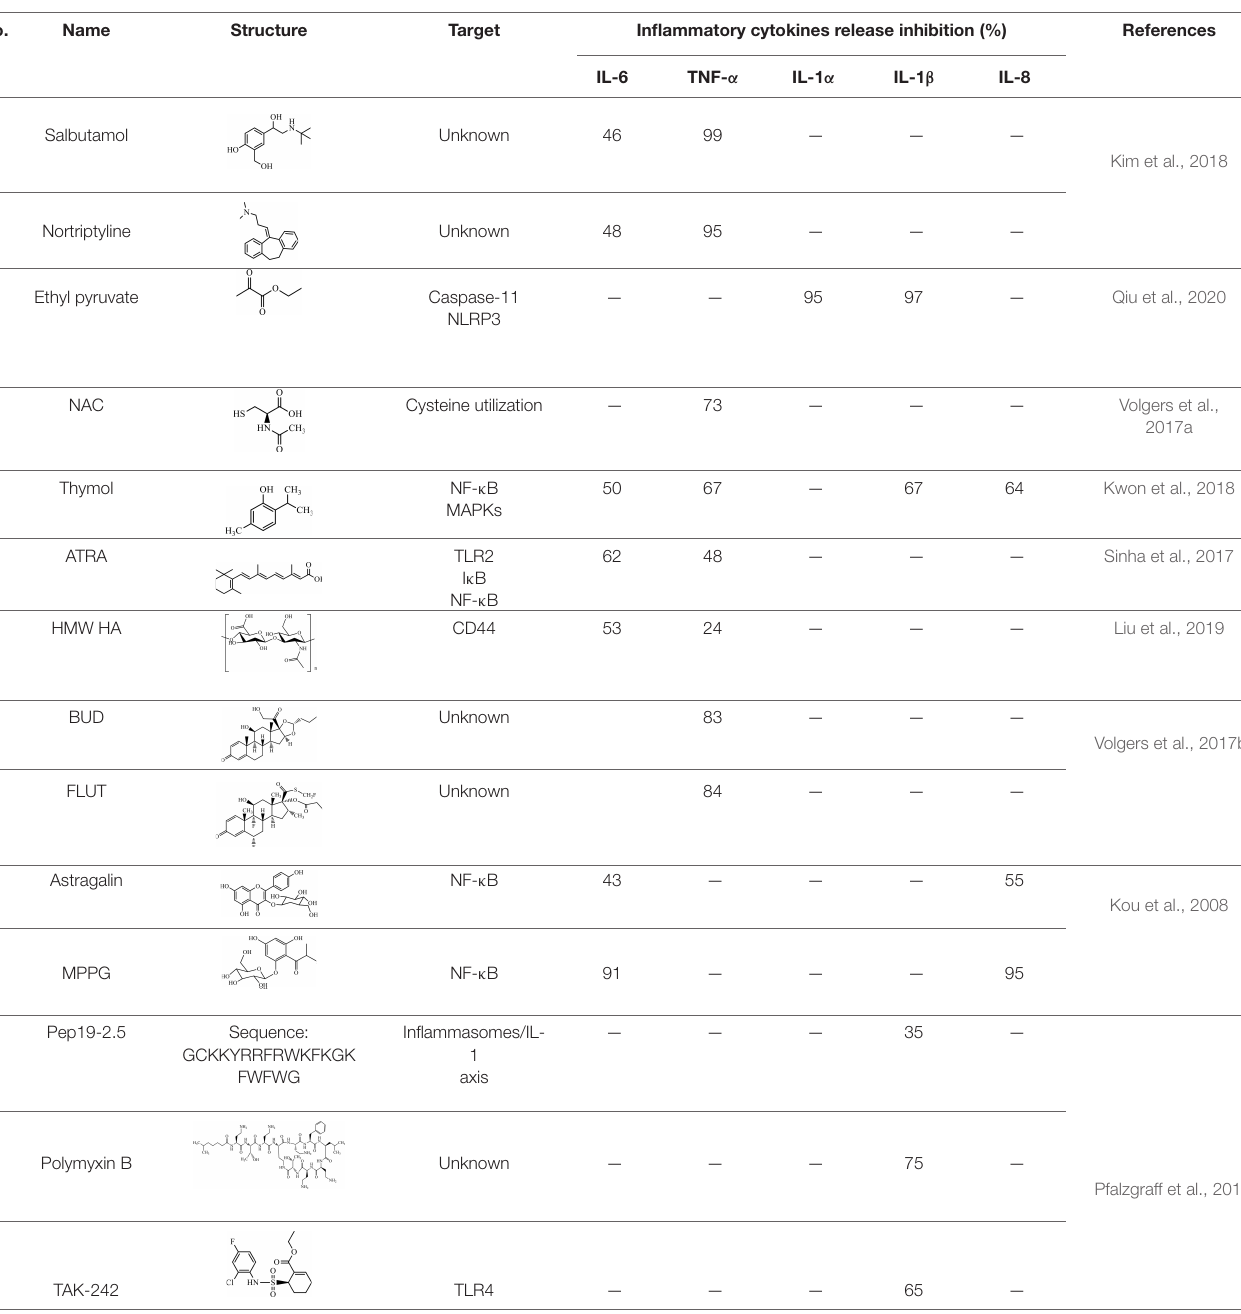
TABLE 4 | EV-stimulated inflammation inhibitors. No.